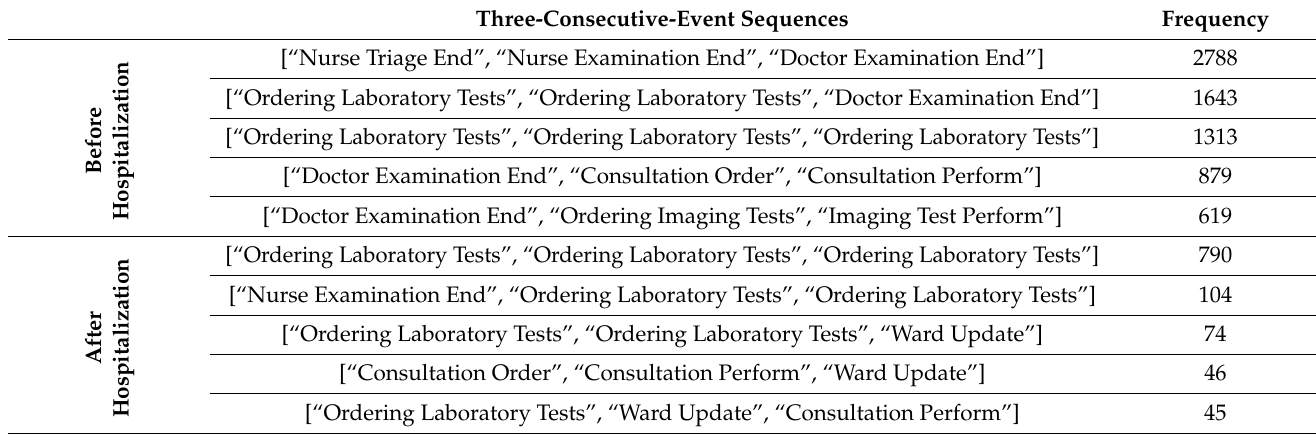
Table 4. Top five most common before and after three-consecutive-event sequences of a hospital- ized patient.